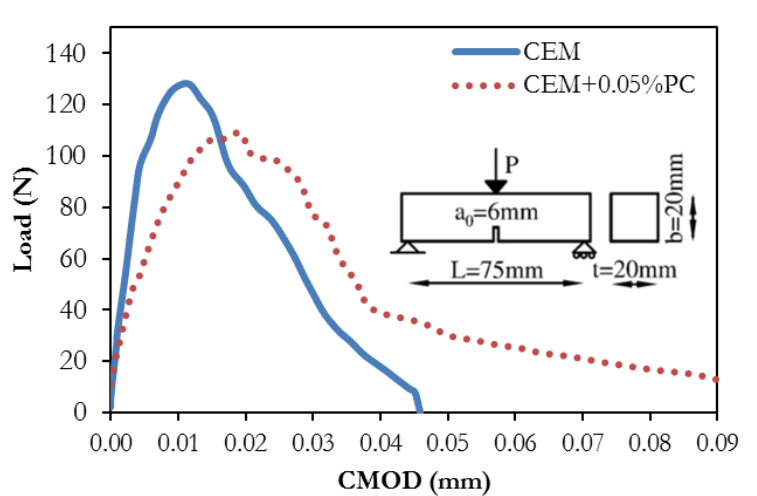
Figure 5: Typical load-CMOD curves for cement composites with and without pyrolyzed coconut shells particles.